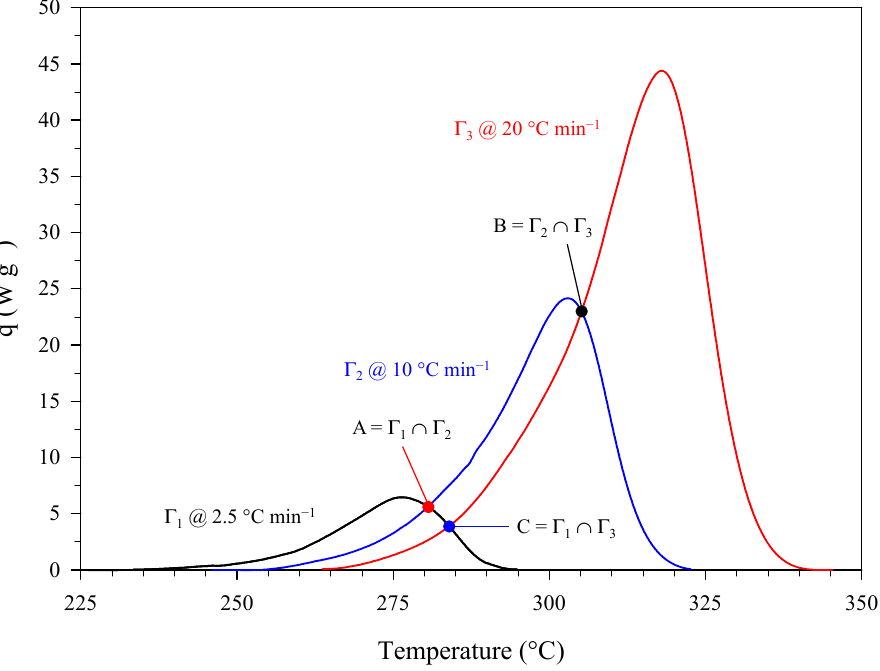
Figure 2. Specific heat power curves (mean curves) collected during a set of dynamic DSC experi- ments carried out on samples of PA at different heating rates.